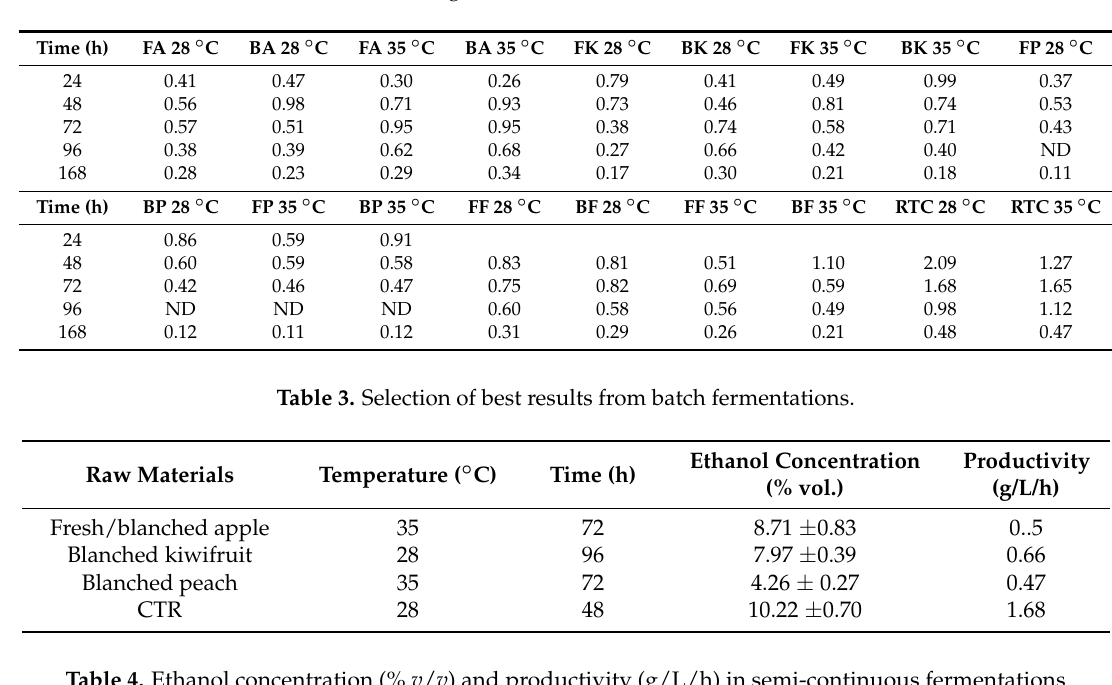
Table 4. Ethanol concentration (% v / v ) and productivity (g/L/h) in semi-continuous